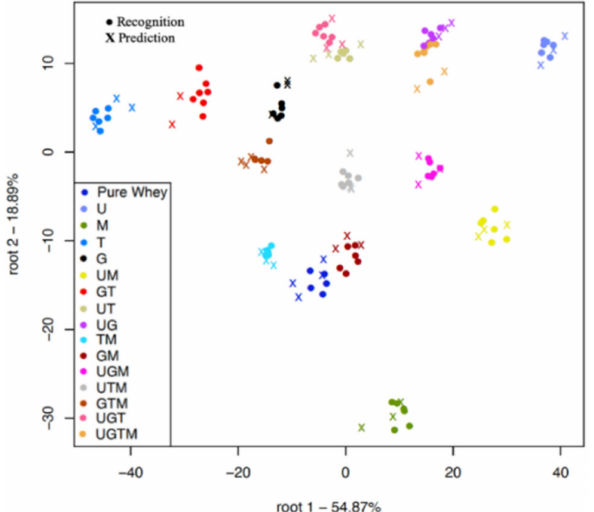
Figure 3. Classification plot of the benchtop spectrometer for the 15-mixture combination using the data of samples with the lowest adulteration level of 0.5% w / w and the pure whey protein powder. U = urea, G = glycine, T = taurine, M = melamine. Spectral pre-processing: Savitzky-Golay smoothing (second order